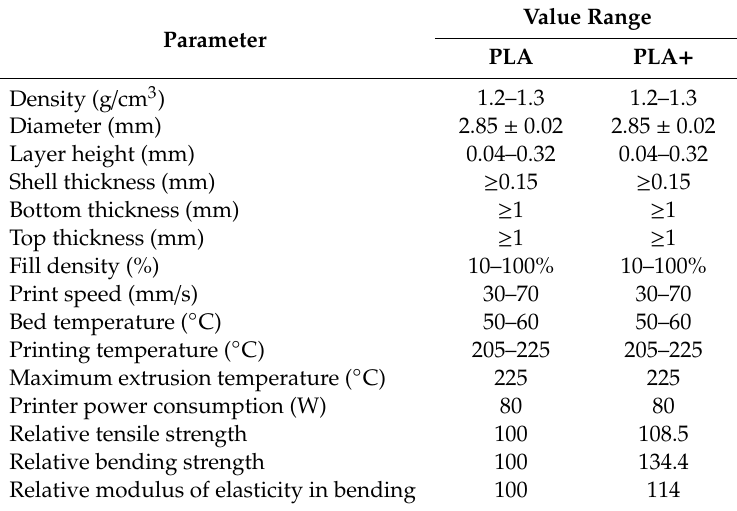
Table 1. Selected process parameters for three-dimensional (3D) printing using polylactic acid (PLA) and PLA + (before optimization) (own work based on